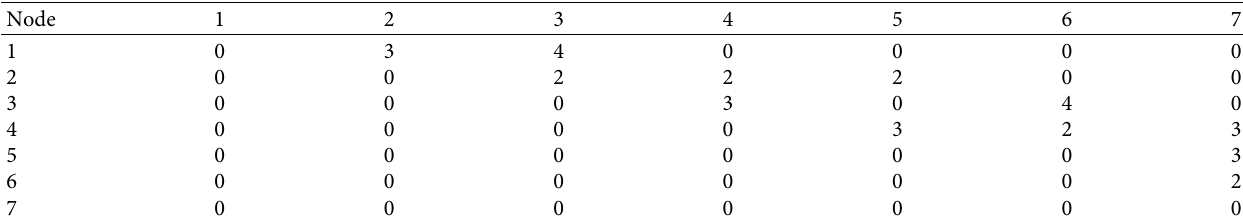
Table 5: Logistics network adjacency list (7-node).